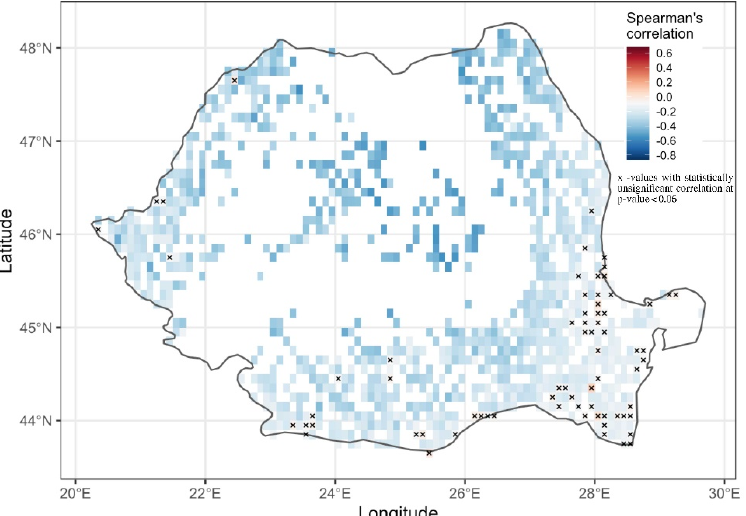
Figure 11. Spatial extent of Spearman’s correlation values between precipitation amount and the 1-composite lag of the NDDI for March and September (2001–2020).